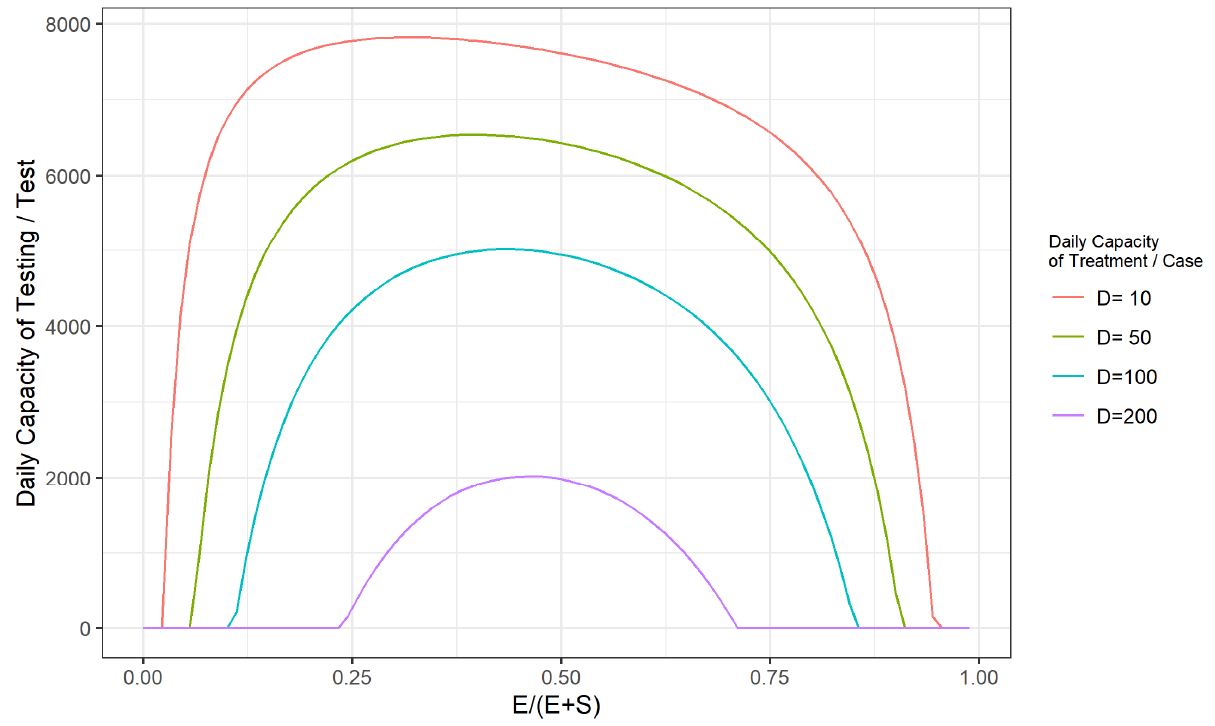
Figure A13. Relationship between the daily testing capacity of the epidemic and the potential level of the epidemic development ( S + E = 9999, I = 0).